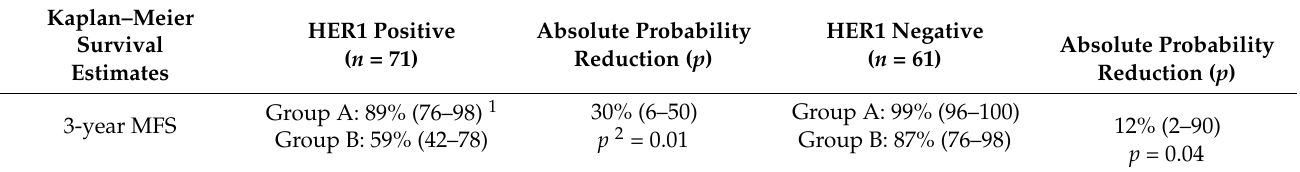
Table 4. Kaplan–Meier estimates of the marginal effect of cetuximab + RT and up-front surgery therapies on metastasis-free survival rates in two subgroups of patients subdivided according to HER1 status of